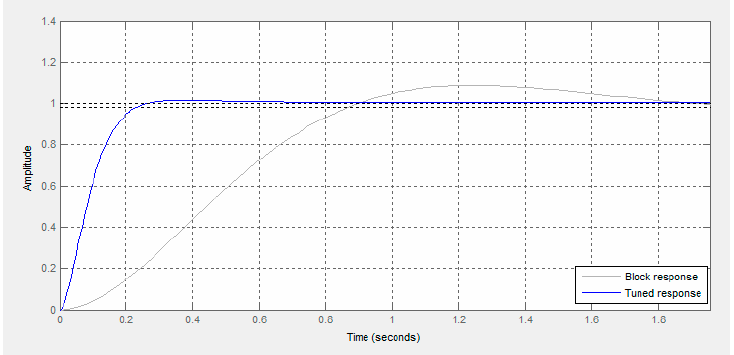
Figure 14. Fluctuating response of the object for chosen PID controller settings. Table 2. PID regulator settings chosen with the auto-tuning method in Matlab/Simulink.